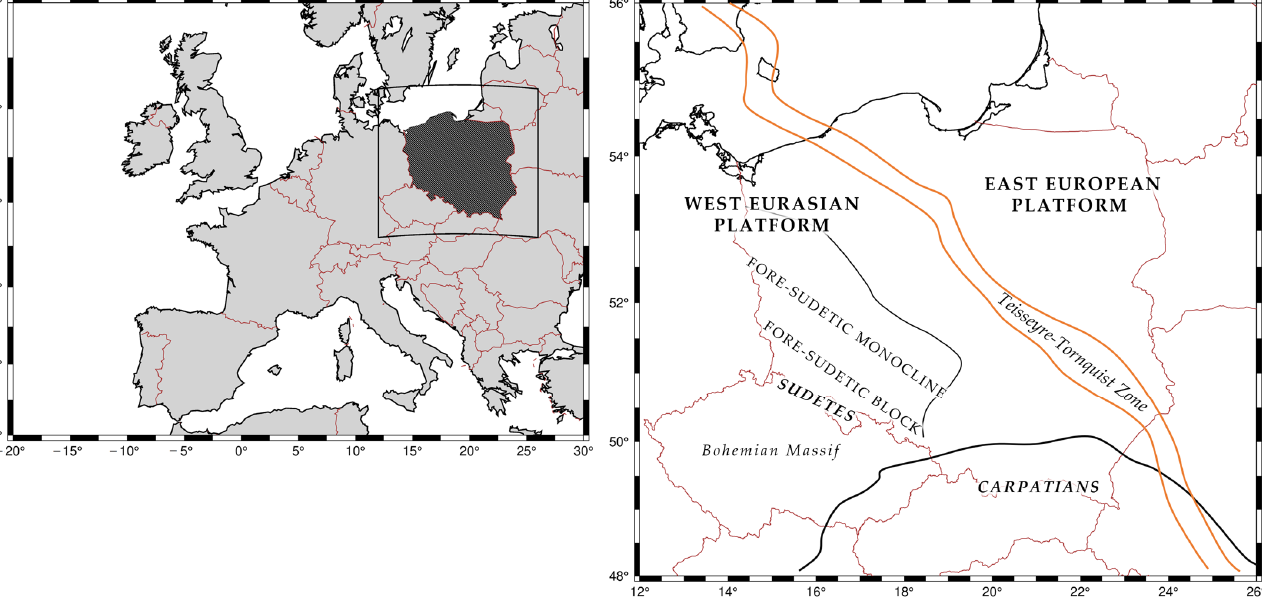
Figure 1. Simplified tectonic map of Poland based on [17,18].